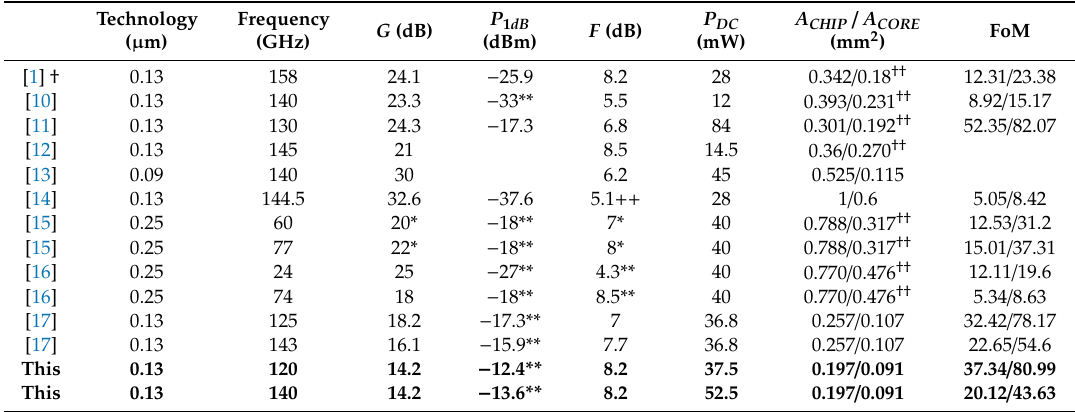
Table 1. Comparison with other cascaded SiGe BICMOS mm-wave